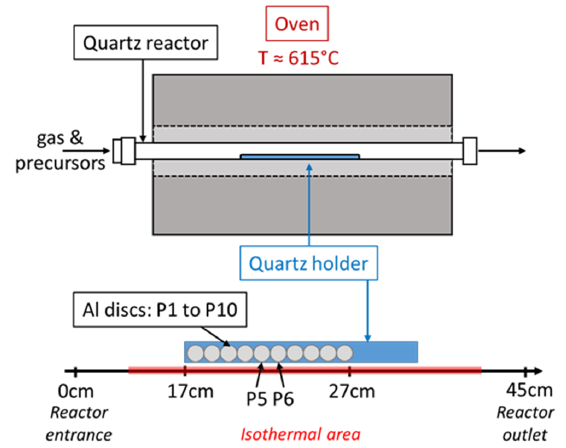
Figure 1. CCVD synthesis set-up and position of the Al substrates (discs) in the isothermal area. P5 is LG-Al substrate and P6 is HG-Al substrate.